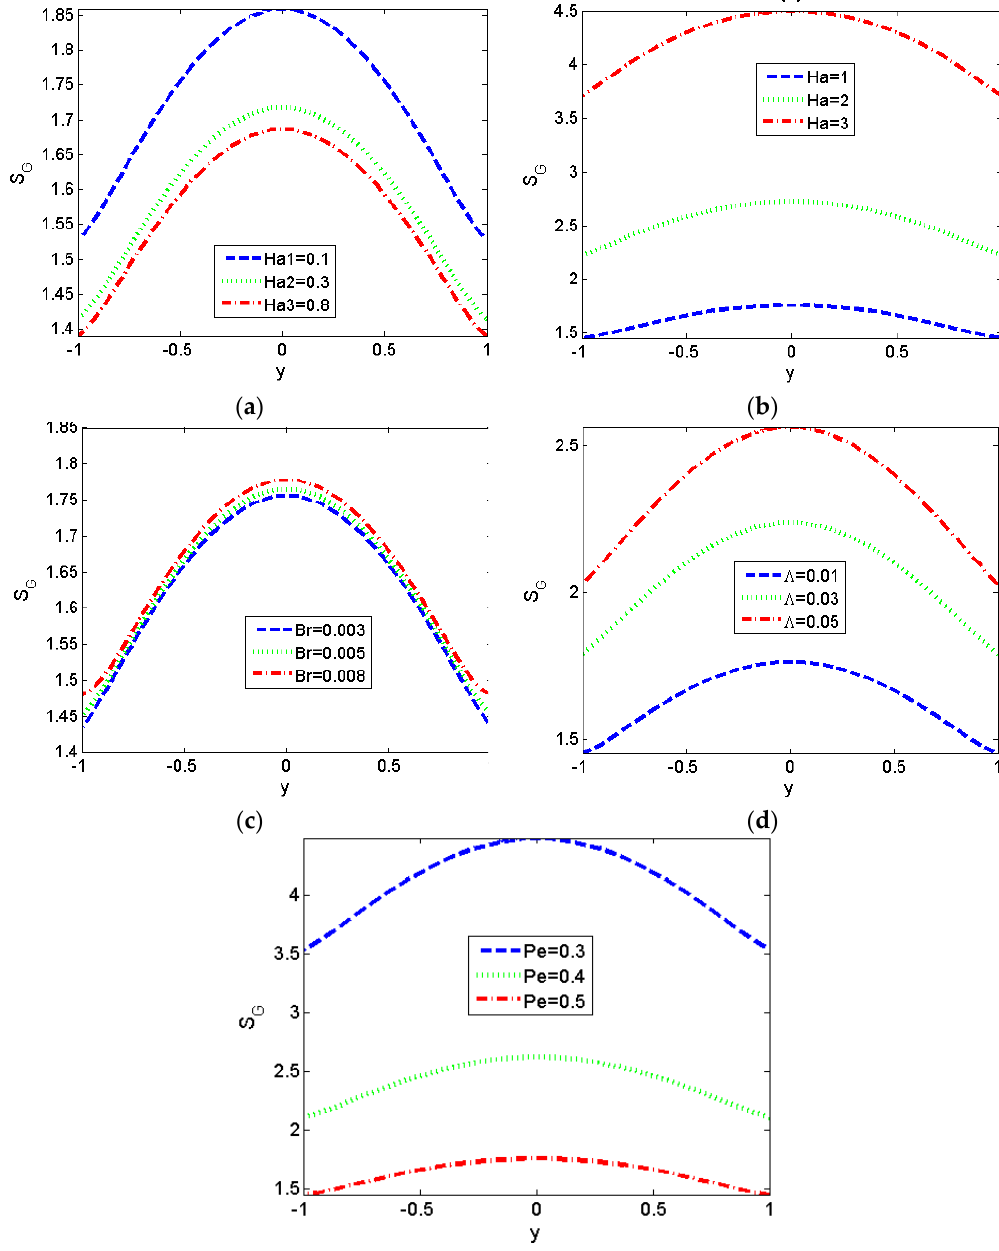
Figure 8. Variations of local entropy generation S G for different values of Ha, Br and Λ . ( S = 1). ( a , b ) Λ = 0.01, Br = 0.005, Pe = 0.5; ( c ) Λ = 0.01, Ha = 1, Pe = 0.5; ( d ) Br = 0.005, Ha = 1, Pe = 0.5; ( e ) Λ = 0.01, Ha = 1, Br = 0.005.